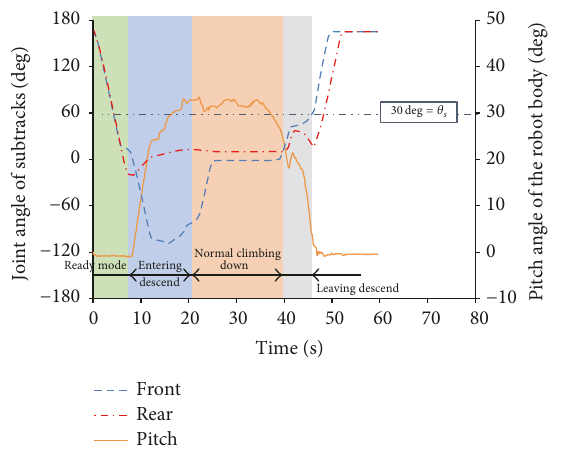
Figure28:Dataprofilefor 𝜃 𝑓 , 𝜃 𝑟 , 𝜃 𝑝 ( 𝜃 𝑠 =30 ∘ , 𝑝 =300mm,descend).